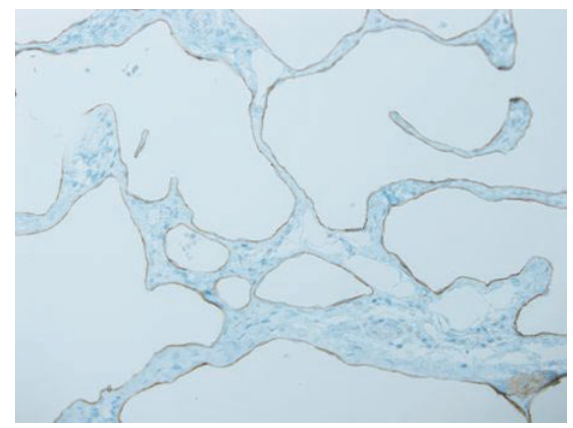
Figure 5. Immunohistochemical reaction positivity with